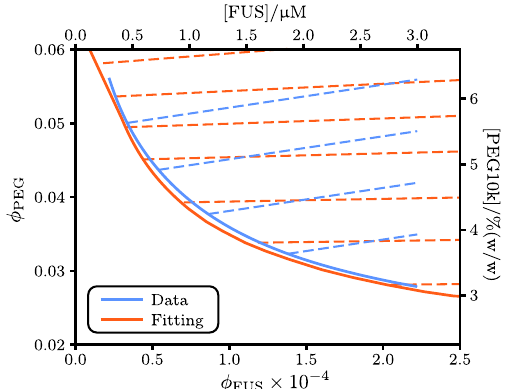
FIG. 6. Numerical fitting results of the phase boundary and tie lines.